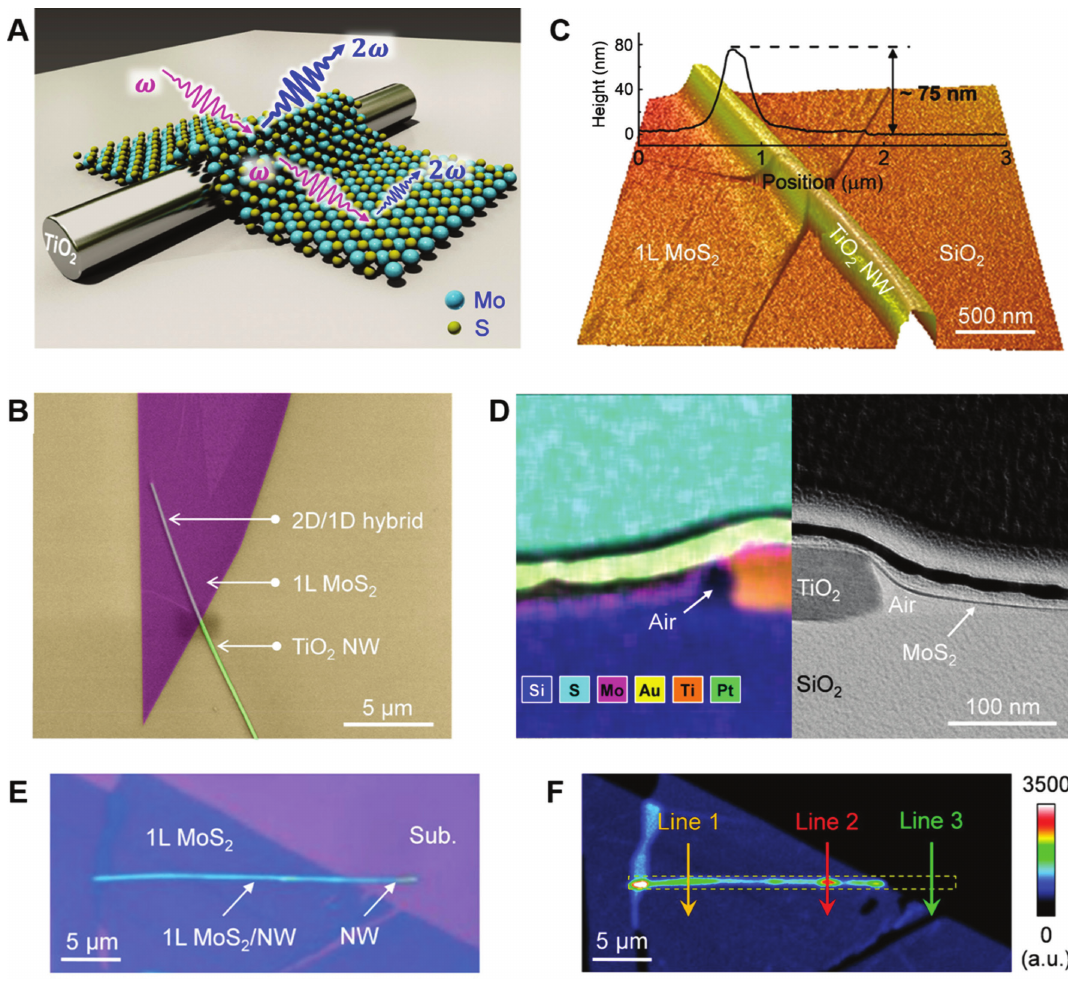
integrating with TiO NW for enhanced SHG. Figure 8: Monolayer MoS 2 2 (A) Schematic diagram of a monolayer MoS integrated with single TiO NW and excited by the fundamental wave ω , where scattered SHG 2 2 signal 2 ω can be collected. (B) False-color SEM micrograph and (C) AFM topography for hybrid structure of monolayer MoS /TiO NW on 2 2 SiO substrate. Inset shows the height profile. (D) Cross-sectional HR-TEM micrograph (right) and overlapped energy-dispersive X-ray 2 spectrometry mapping (left) for the same structure in (B). (E) Optical micrograph of MoS /TiO hybrid structure on a SiO substrate with 2 2 2 (F) the SHG mapping. Reprinted with permission of Ref.